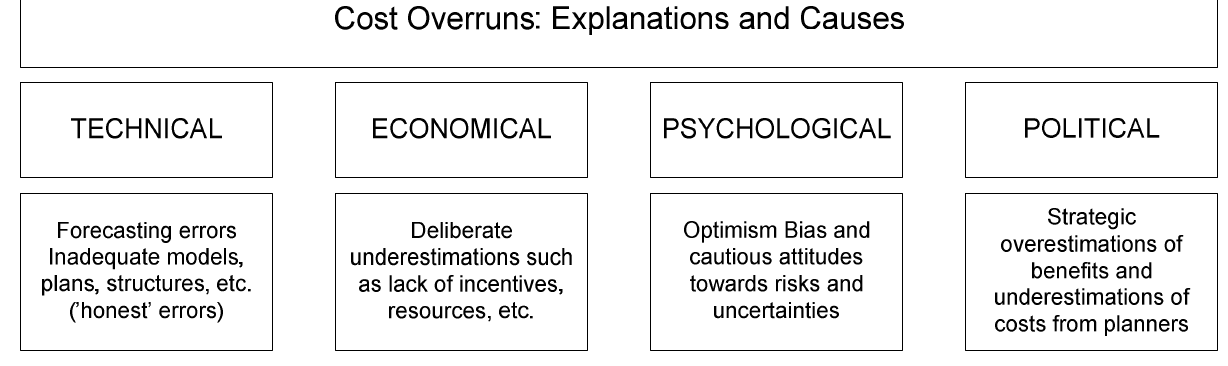
Figure 3. Categorising of the four types of explanations to cost overruns and their causes (adapted from Cantarelli et al.